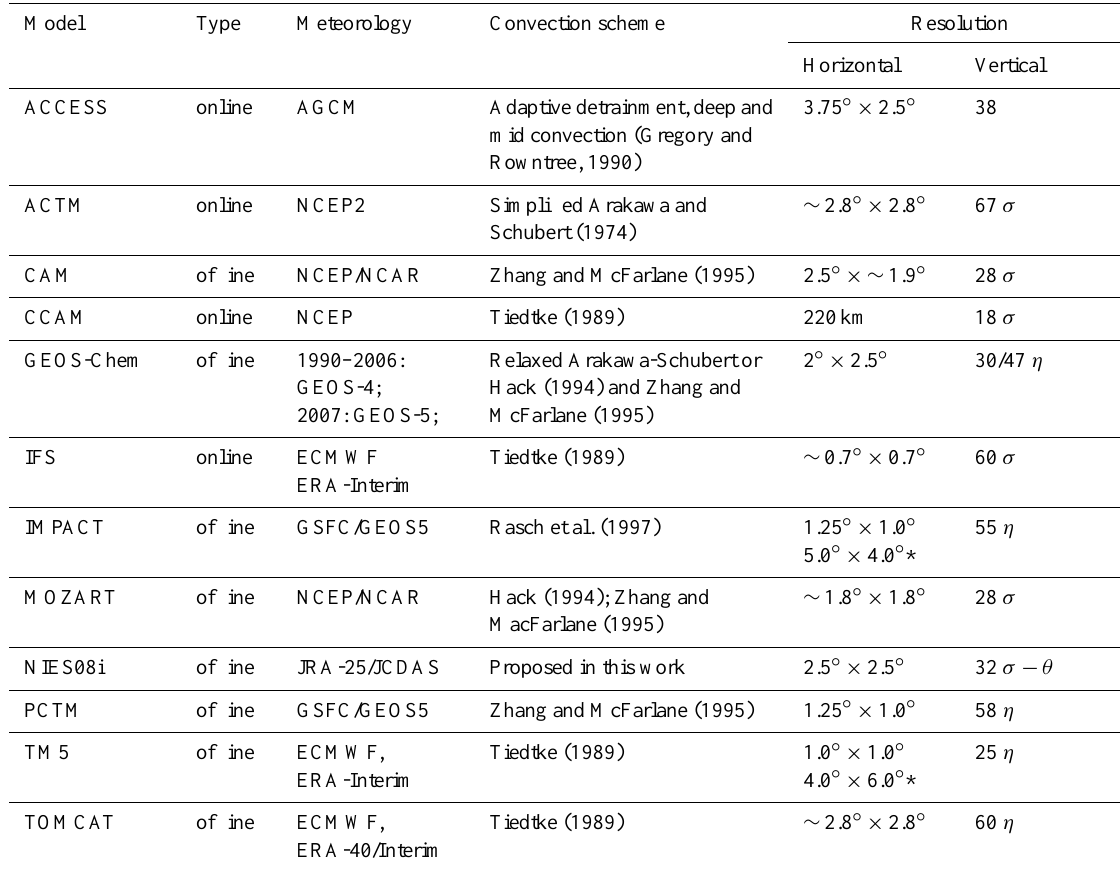
Table 2. Model descriptions.